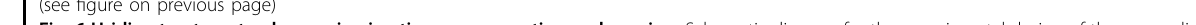
Fig. 6 Uridine treatment enhances in vivo tissue regeneration and repair. a Schematic diagram for the experimental design of the mouse liver fi brosis (LF) modeling and vehicle or uridine treatment. b Bar charts of liver weight (left) and liver index (right) of sham mice ( n = 10 mice) and liver fi brotic mice treated with vehicle ( n = 9 mice) or uridine ( n = 10 mice). c Representative images of Masson staining of the liver from sham mice ( n = 10 mice) and liver fi brotic mice treated with vehicle ( n = 9 mice) or uridine ( n = 10 mice). Quantitative data of the relative fi brotic area are shown to the right. Scale bars, 200 μ m. d Diagnostic tests for liver functions of sham mice ( n = 10 mice) and liver fi brotic mice treated with vehicle ( n = 9 mice) or uridine ( n = 10 mice). e Schematic diagram for the time course of the mouse hair regeneration experiment. f Hair-growth effect of mice topically treated or subcutaneously injected with vehicle or uridine. Hair-growth rates upon vehicle or uridine treatment were veri fi ed by pigmentation scoring. Subcutaneous injection (Vehicle, n = 7 mice; Uridine, n = 8 mice). Topical treatment (Vehicle, n = 6 mice; Uridine, n = 10 mice). g Representative images of H&E staining of the hair follicle of mice subcutaneously injected with vehicle or uridine at day 14 post treatment. Scale bars, 400 μ m. h Pie plots showing the hair follicle phase of mice subcutaneously injected with vehicle or uridine at day 14 post treatment. Mean values of hair follicle phases for mice subcutaneously injected with vehicle ( n = 7 mice) or uridine ( n = 8 mice) are shown. i Ki67 and KRT15 staining of the hair follicle of mice subcutaneously injected with vehicle ( n = 7 mice) or uridine ( n = 8 mice) at day 14 post treatment. Scale bars, 200 μ m. j Schematic diagram for the experimental design of anterior cruciate ligament transection (ACLT) mediated osteoarthritis (OA) modeling and vehicle or uridine treatment. k Representative images of Safranin O/ Fast Green staining of articular cartilage from the joints of sham mice ( n = 10 mice) and OA mice treated with vehicle ( n = 10 mice) or uridine ( n = 10 mice). Quantitative data of cartilage thickness are shown to the right. Scale